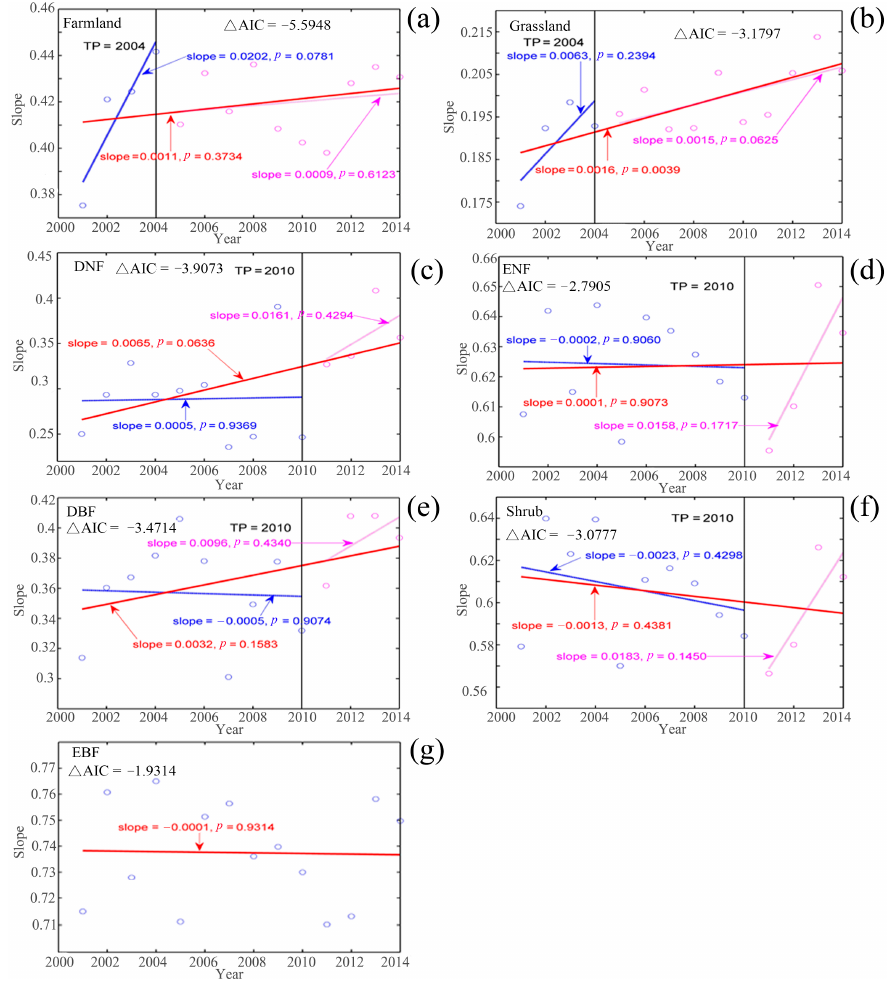
Figure 6. Inter-annual variations of Net Primary Productivity (NPP) in China at the biome level (Farmland ( a ), Grassland ( b ), Deciduous needle-leaf forest ( c ), Evergreen needle-leaf forest ( d ), Deciduous broadleaf forest ( e ), Shrub ( f ), and Evergreen broadleaf forest ( g )). Trends estimated by the least-squares linear regression are shown. The blue and pink lines indicate the linear fit before and after the turning year, respectively. The red line indicates linear fit during the period 2001–2014. TP represents the turning point year.